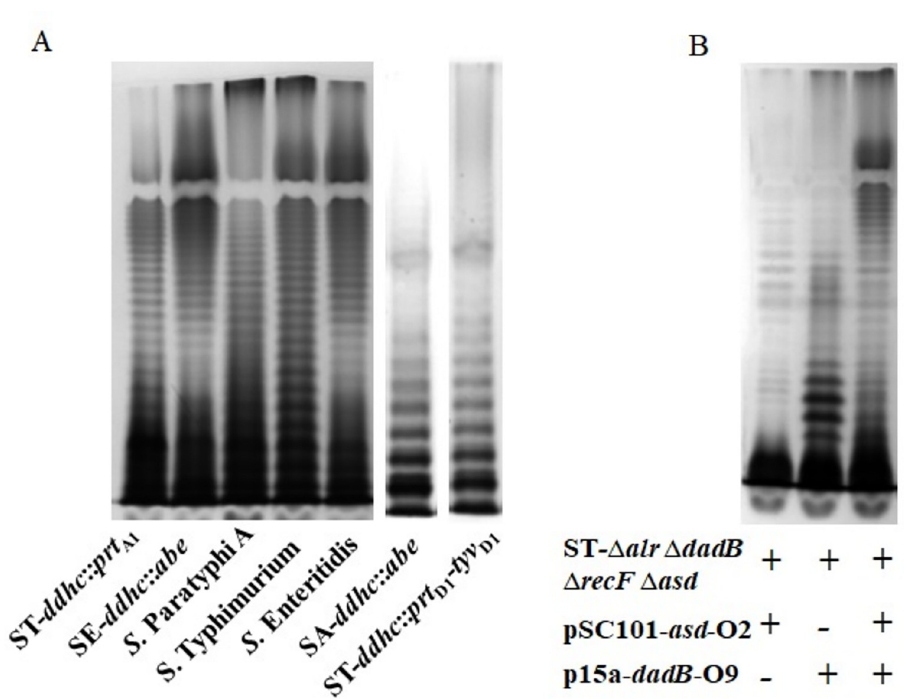
Fig 3. LPS profiles of S . enterica mutants. S . enterica mutants exhibiting double or triple immunodominant O- serotypes were constructed by chromosomally gene insertion mutations (A) or plasmid overexpressing systems (B). The LPS extracted from these mutant strains was separated on a 12.5% (w/v) polyacrylamide gel by tricine-SDS-PAGE and visualized by the silver staining. Bands represented the LPS with different numbers of O-unit